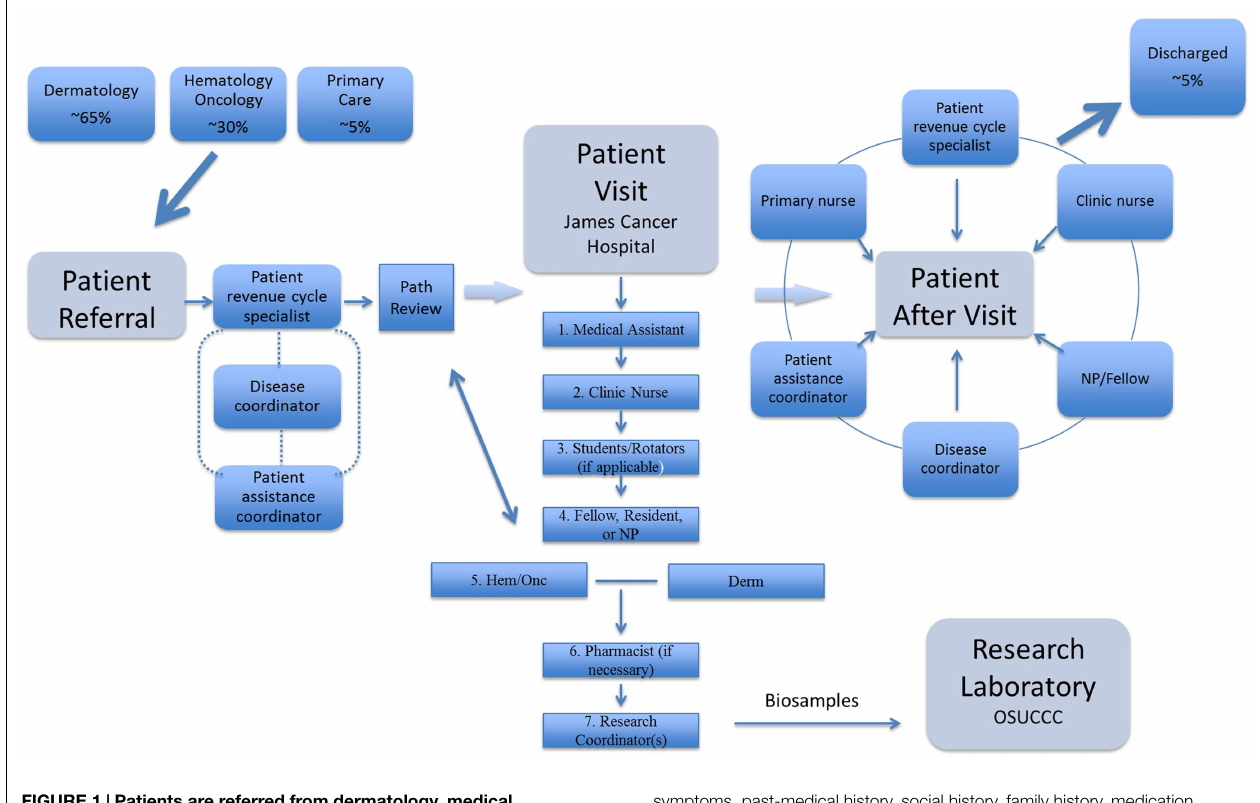
FIGURE 1 | Patients are referred from dermatology, medical oncology, and primary care . After patient referral, the patient revenue specialist requests outside pathology to be reviewed at our institution, requests medical records, and schedules appointment time. Our expert cutaneous hematopathologist reviews outside pathology prior to initial patient visit and then will on some occasions see the patient during first visit. Patients in need of financial assistance are handled by our patient assistance coordinator. The disease coordinator acts to ensure the initial patient referral is following a smooth transition. Then, at time of the patient visit, the medical assistant greets and escorts the patient into the